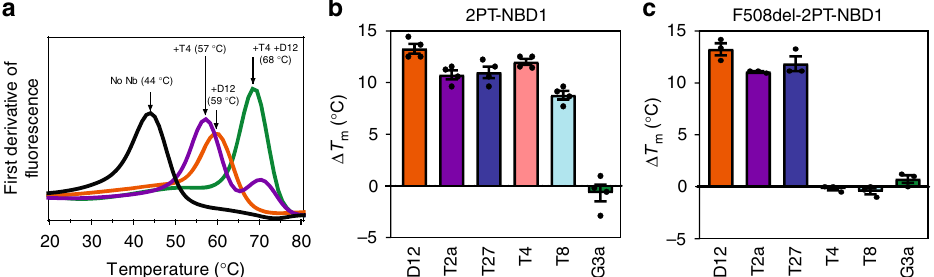
Fig. 2 Stabilization of isolated 2PT-NBD1 and F508del-2PT-NBD1 variants by nanobodies. a Differential scanning fl uorescence (DSF) of puri fi ed 2PT-NBD1. The protein (alone or in complex with one or two different nanobodies) was incubated with SYPRO Orange dye and fl uorescence was measured as a function of temperature. The melting temperatures (Tm) were determined by the maxima of the fi rst derivative of fl uorescence. Curves depict mean of duplicates of one experiment representative of at least three independent experiments. b Summary of melting temperature differences ( Δ Tm) of 2PT- NBD1 in presence of different nanobodies determined using DSF as in ( a ). Data are mean ± SEM of duplicates from four independent experiments. c Summary of melting temperature differences ( Δ Tm) of F508del-2PT-NBD1 in presence of different nanobodies using DSF as in ( a ). Data are mean of duplicates ± SEM ( n = 4). Source data are provided as a Source Data fi le